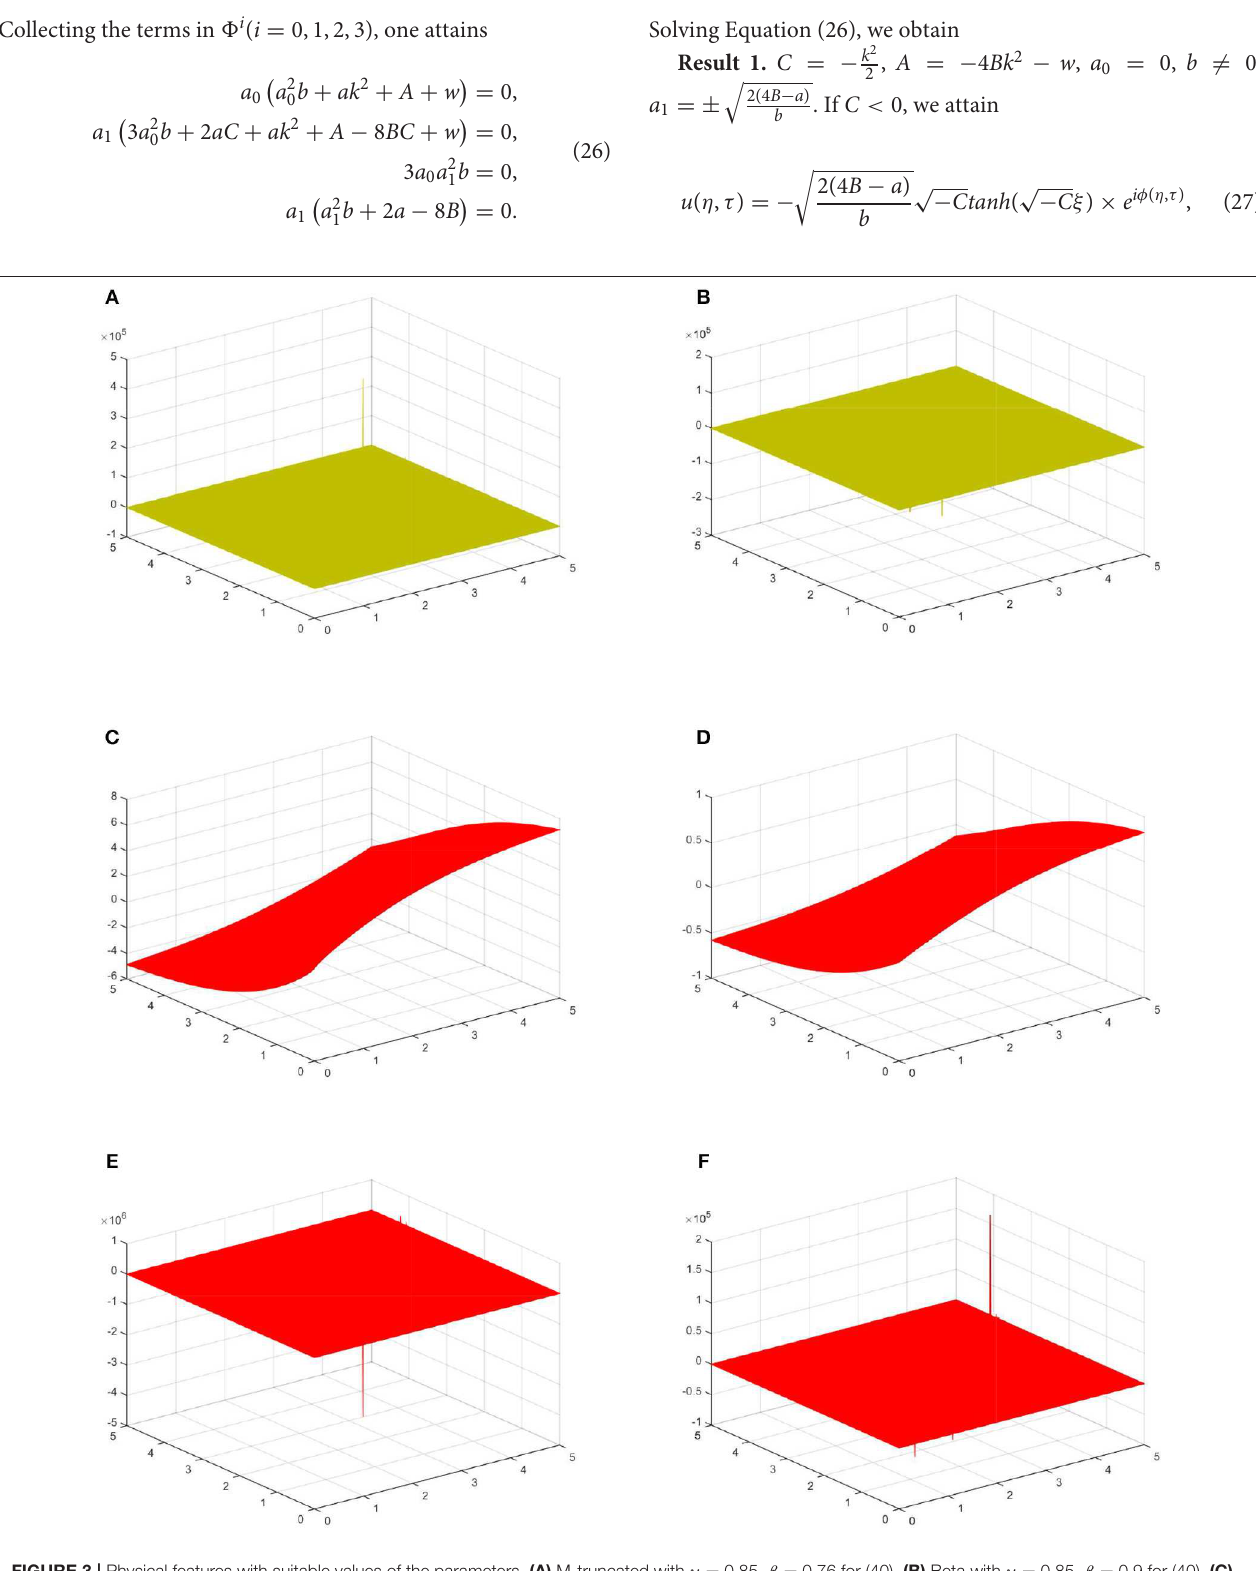
FIGURE 3 | Physical features with suitable values of the parameters. (A) M-truncated with γ M-truncated with γ for